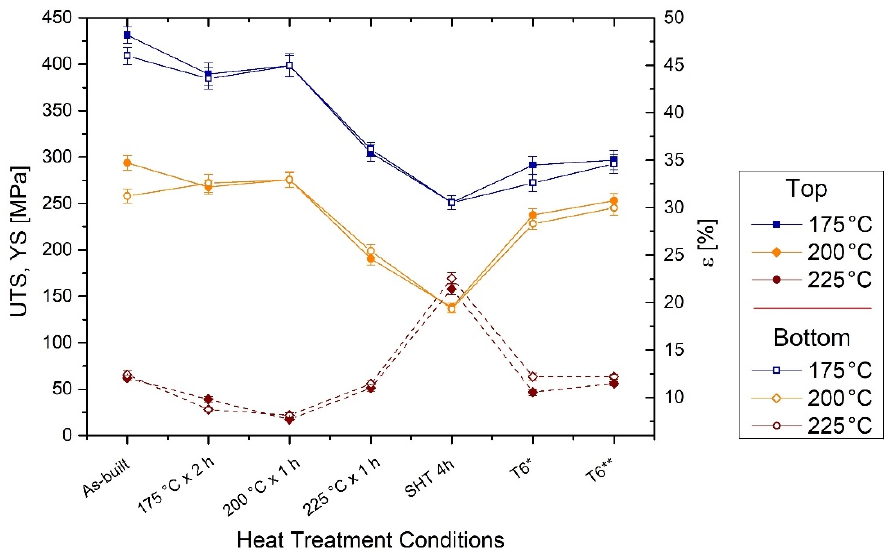
Figure 12. UTS, YS and elongation ( ε ) values of the AlSi7Mg0.6 samples in as ‐ built conditions, and after the optimal conditions of the DA, solution, T6* (SHT + 175 °C × 4 h) and T6** (SHT + 175 °C × 8 h) heat treatments.